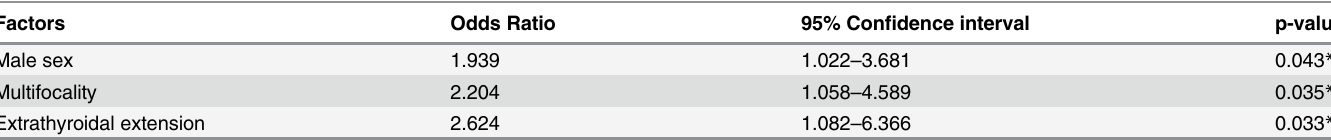
Table 4. Multivariate analysis of the clinicopathological factors for patients with SLN